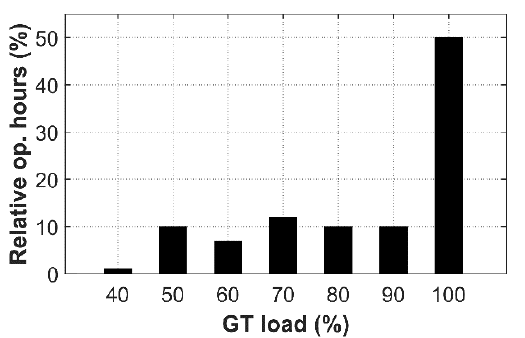
Figure 12. Reference yearly demand profile of a natural gas compressor station (source [36]). Table 5. Results summary.